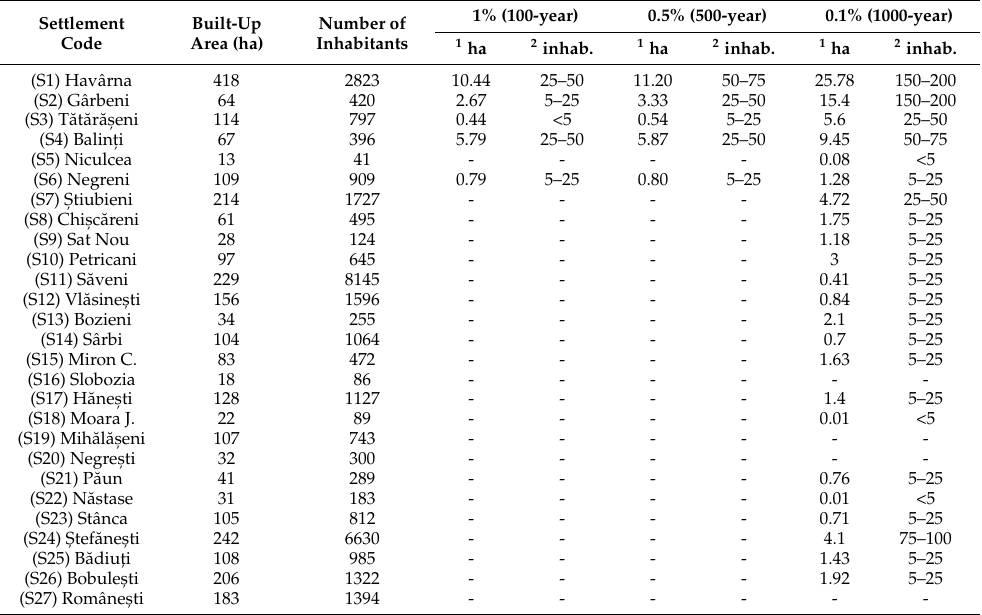
Table 5. Flood extent within built-up area of 27 settlements located downstream of the Cal Alb reservoir and number of inhabitants potentially affected by flood waves computed for each dam break scenario with 1% (100-year), 0.5% (500-year), and 0.1% (1000-year) recurrence intervals. Built-Up Settlement Area Code